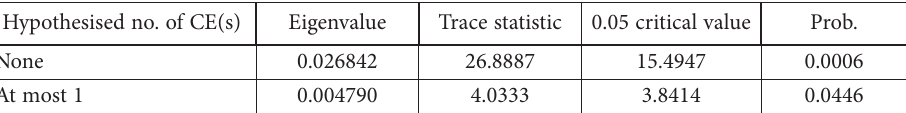
Table 7. Johansen cointegration